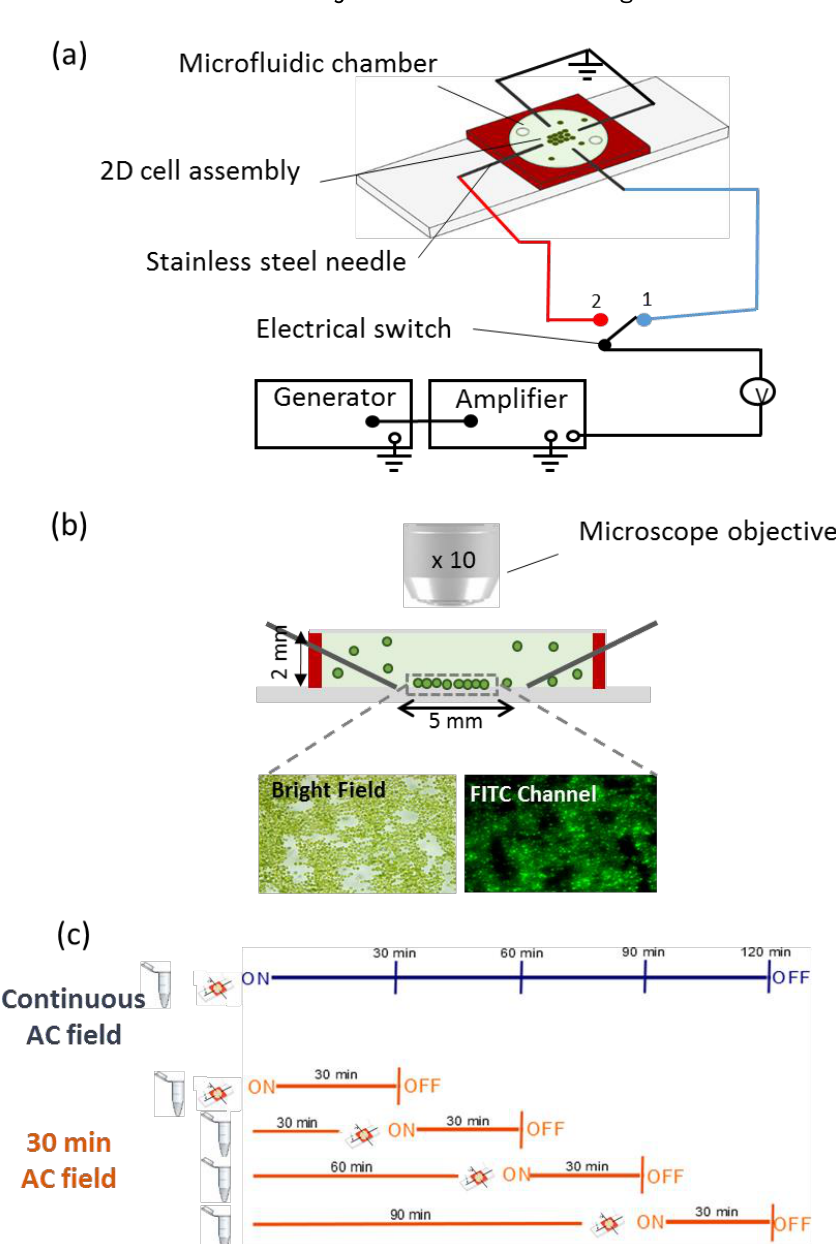
Figure 1. ( a ) Schematics of the experimental set-up. The four orthogonally stainless steel needle electrodes were connected in pairs to the generator and amplifier. The electric field was applied to one pair of electrodes and was switched to the other pair every 2 min allowing the formation of 2D-cell assembly. The cells and media are confined in a microfluidic chamber of silicone rubber (red) with optically transparent top; ( b ) Transverse section of the microfluidic chamber. The 2D-assembly of cells formed in the 5 mm-gap of the four point needle electrodes is observed by microscope using bright field and fluorescence channel FITC. The chamber and the cell sizes are not to scale; ( c ) Experimental plan used to test the effect of the collection time on the cell’s oxidative